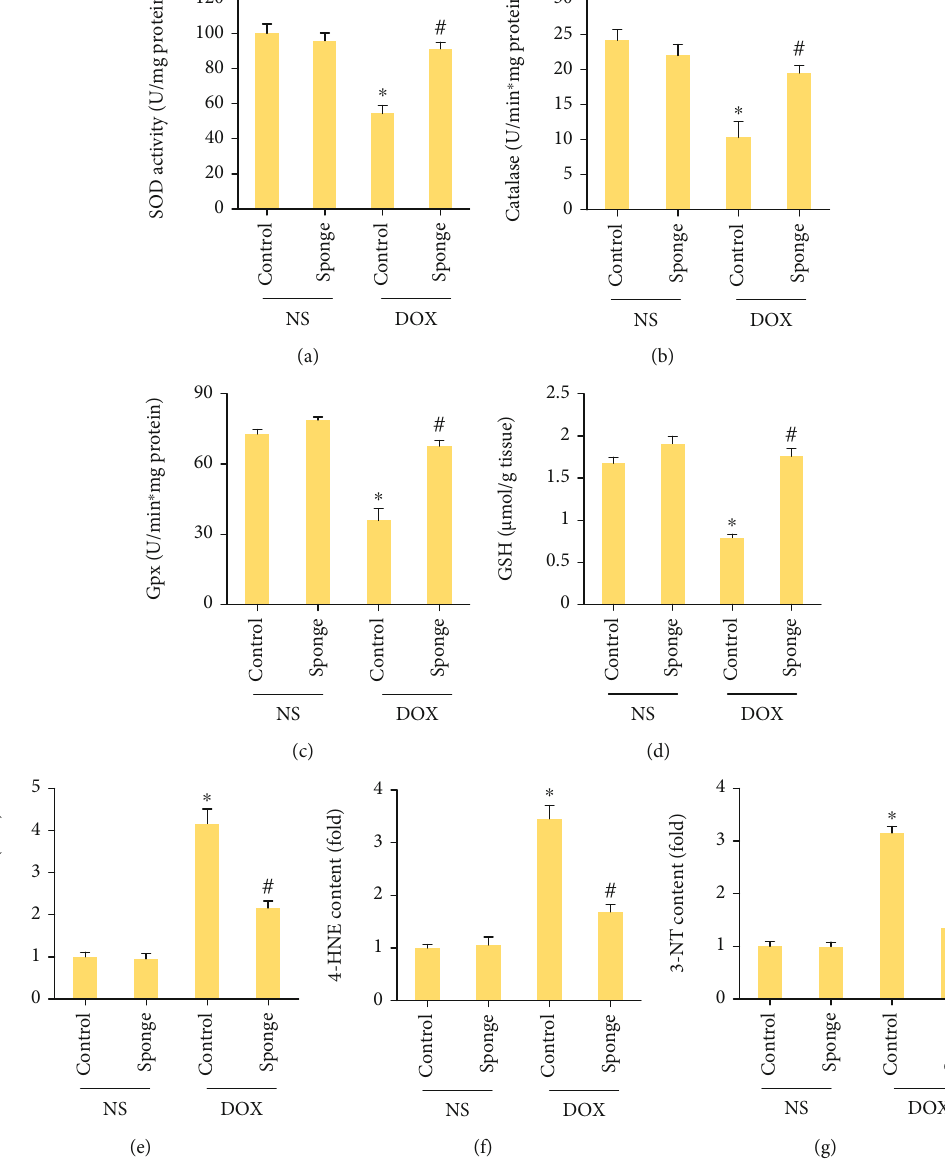
Figure 4: miR-128-3p inhibition attenuated oxidative damage in DOX-treated mice. (a – c) The activities of SOD, catalase, and Gpx in the mice ( n = 6 ). (d) The levels of GSH in mice ( n = 6 ). (e – g) The levels of MDA, 4-HNE, and 3-NT in the indicated groups ( n = 6 ). Data are expressed as mean ± SEM . ∗ P < 0 : 05 vs. NS/control group; # P < 0 : 05 vs. DOX/control